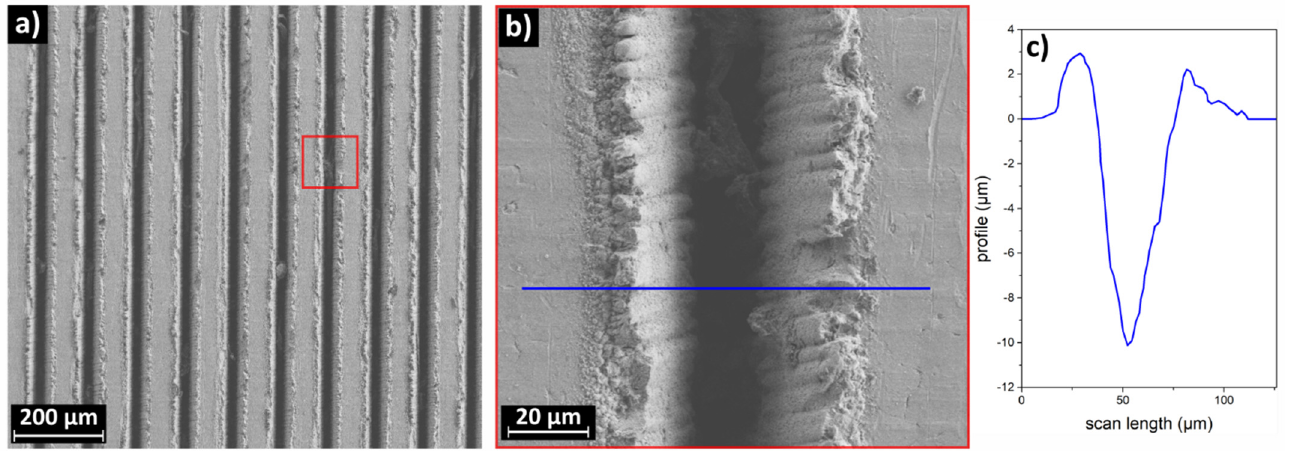
Figure 2. SEM micrograph of the laser engraved AISI 301H sample. ( b ) Magnification of the area marked with the red line in ( a ). ( c ) Profilometry of a representative crater.